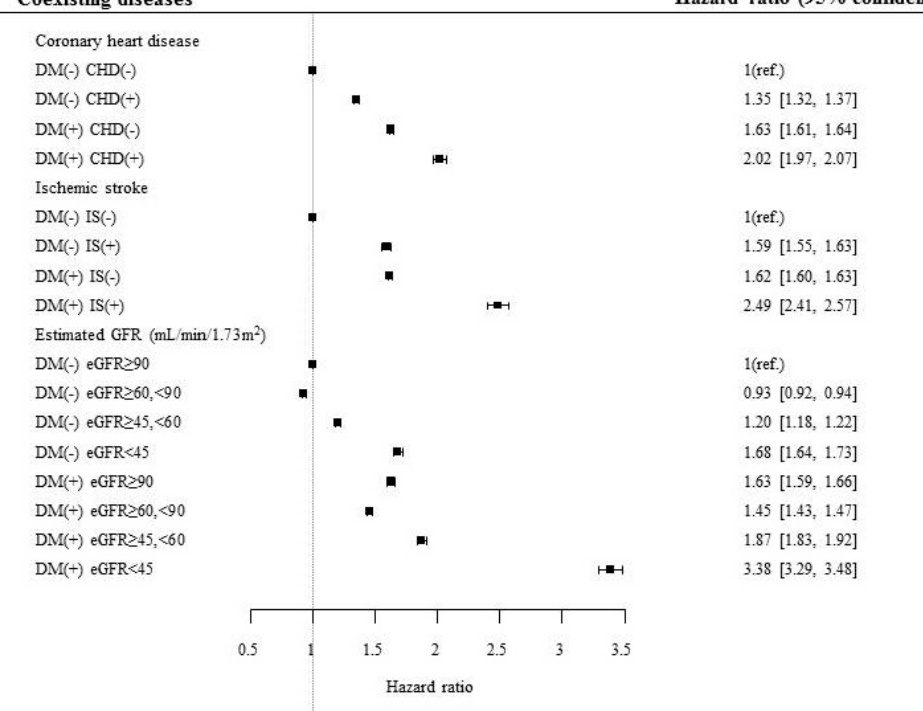
Figure 1. Hazard ratio for mortality according to the presence of diabetes, coronary heart disease, and ischemic stroke. DM, diabetes mellitus; CHD, coronary heart disease; IS, ischemic stroke; eGFR, estimated glomerular filtration rate.